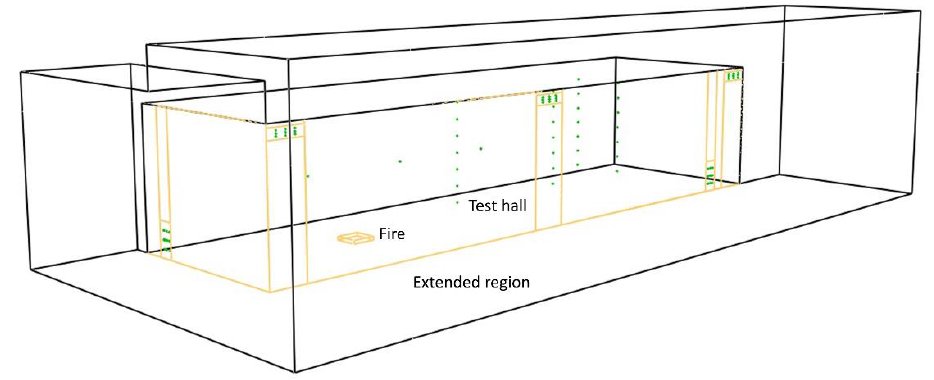
Figure 2. Isomeric view of the computational domain for Configuration 1 .